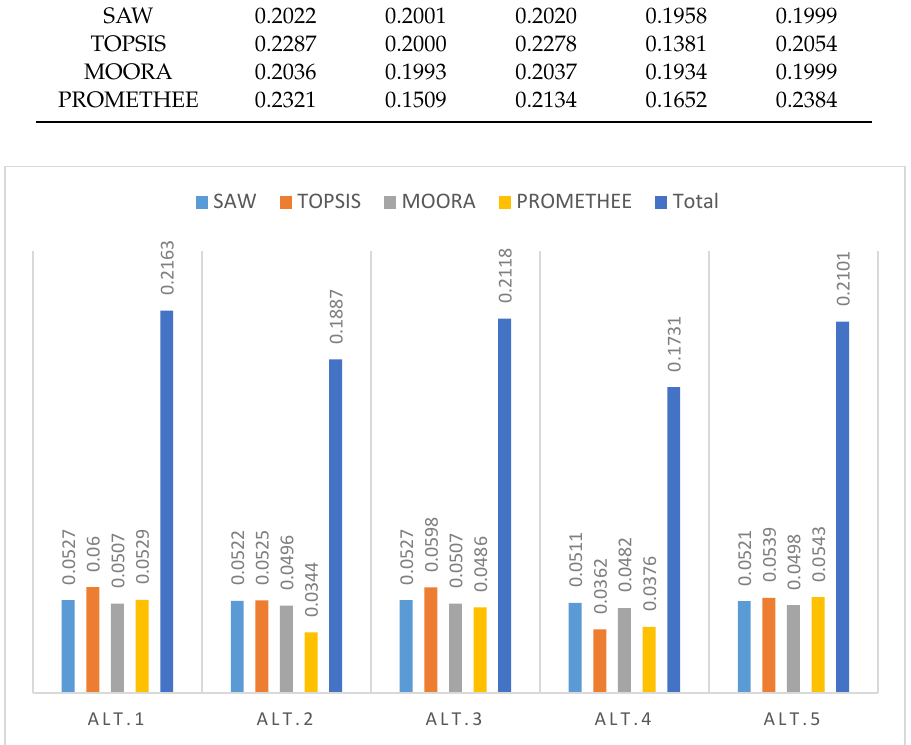
Figure 6. Merging the results of MADM methods following classical normalization.